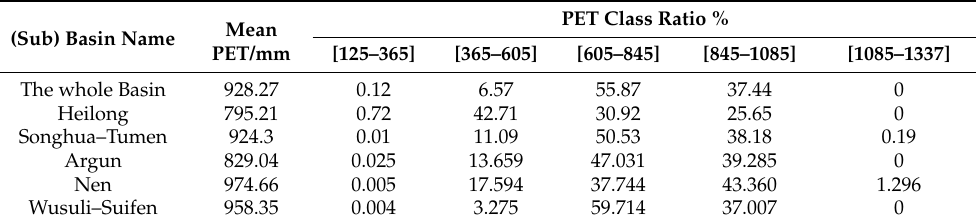
Table 3. Basin/sub-basin mean Potential evapotranspiration (PETs) and class